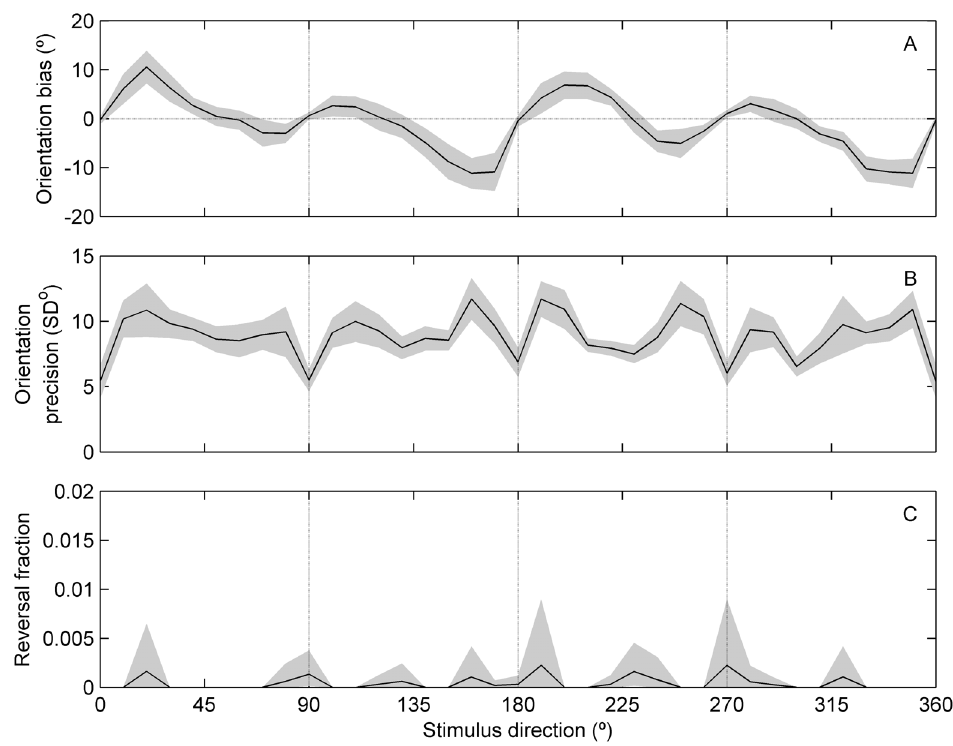
Figure 4. Direction-dependent perceptual performance. Bias, precision and reversal fraction have an anisotropic dependence on stimulus direction. All results show mean 6 SE across 12 participants, based on the control data from Experiment 1 (stimulus duration of 160 ms). (A) Perceptual repulsion from horizontal directions is evident as the large positive slopes near 0 and 180 u , and the smaller, but still positive slopes near 90 and 270 u . (B) The oblique effect is apparent as the higher precision (standard deviation) for oblique directions compared to cardinal directions. (C) Reversals were negligible due to the long stimulus duration.